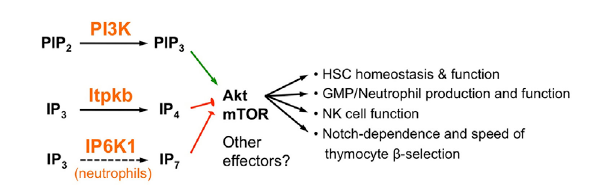
FigURe 4 | Non-canonical antagonism between phosphoinositide 3-kinase (PI3K) and Itpkb or inositol hexakisphosphate kinase-1 (IP6K1) controls multiple aspects of hematopoiesis. PI3K and Itpkb convert the analogous substrates PIP 2 and IP 3 into the analogous products PIP 3 and IP 4 , respectively. By competing with PIP 3 for Akt pleckstrin homology domain binding, IP 4 then dampens PI3K-mediated Akt activation and signaling via mammalian or mechanistic target of rapamycin (mTOR). This ensures hematopoietic stem cell (HSC) homeostasis and function, warrants appropriate GMP/neutrophil and NK cell production and function, and establishes the Notch-dependence and kinetics of thymocyte β -selection (22, 23, 25–27). In neutrophils, IP6K1 can also antagonize PI3K activation of Akt by producing the additional PIP 3 analog IP 7